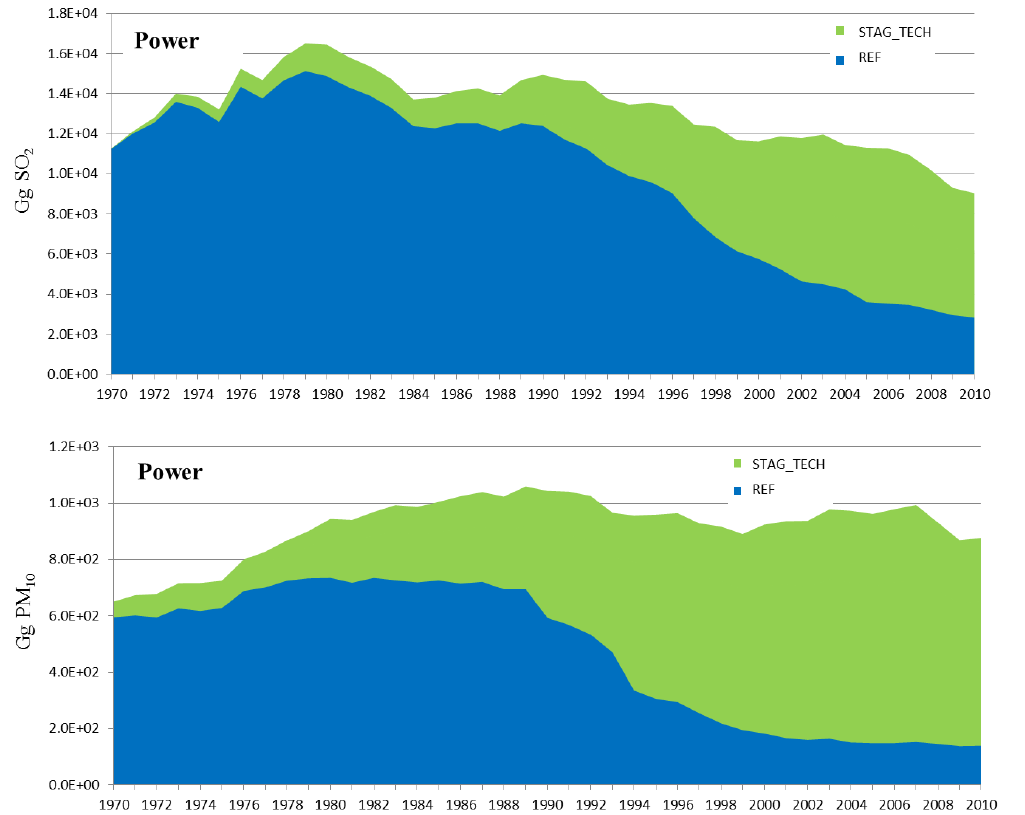
Figure 5. Effect of air quality abatements (STAG_TECH scenario) on annual power generation emissions in Europe (EU27), SO 2 (upper panel) and PM 10 (lower